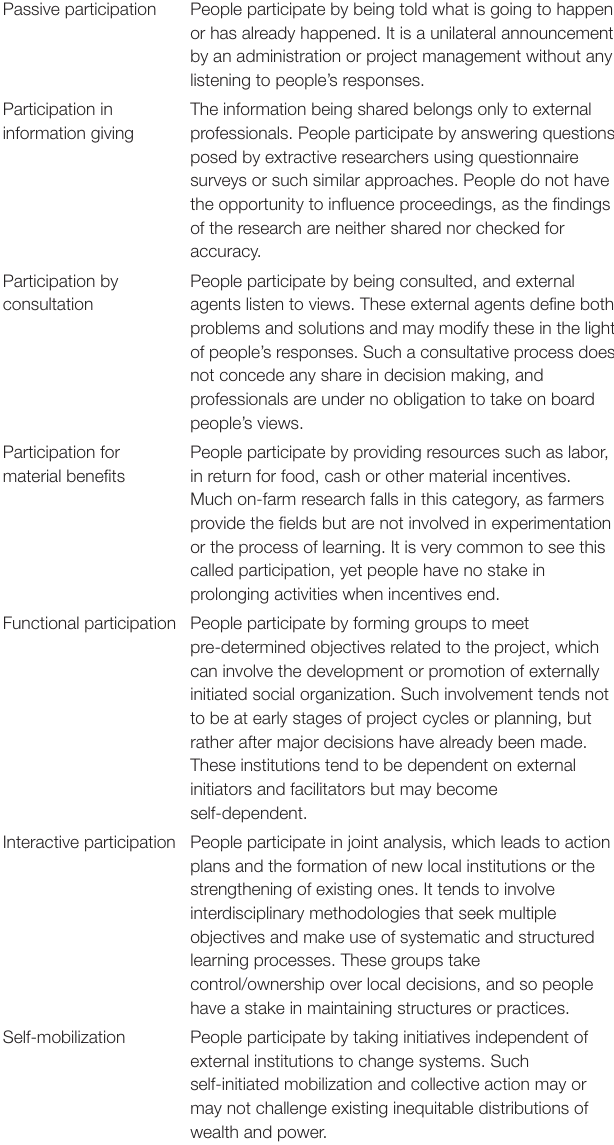
TABLE 1 | A typology of participation: how people participate in development programs and projects (16). Passive